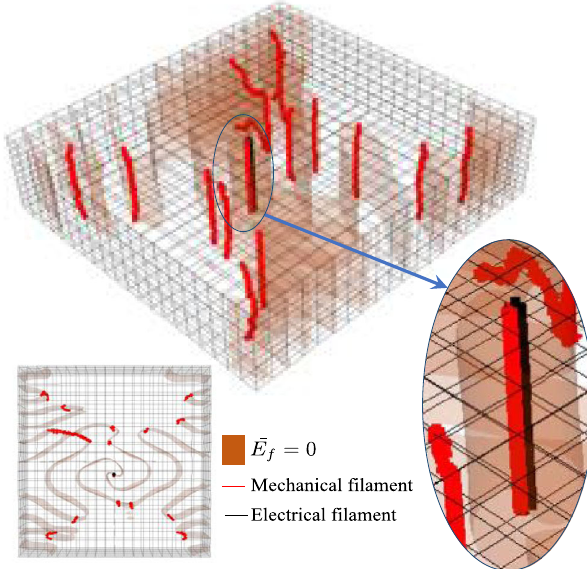
points.FIG. 9. Electromechanical phase singularities in the presence of a single scroll wave with short wavelength in a 3D tissue ( 4 . 5 × 4 . 5 × 1 . 2 cm; inset figure is the top view) with all fibers being aligned along the x axis. Red lines represent lines of mechanical phase singularity or mechanical filaments, and the black line at the center represents the electrical vortex filament or scroll wave core. The isosurface is presenting ¯ E where is the normalized strain along the fiber that is used to f calculate the